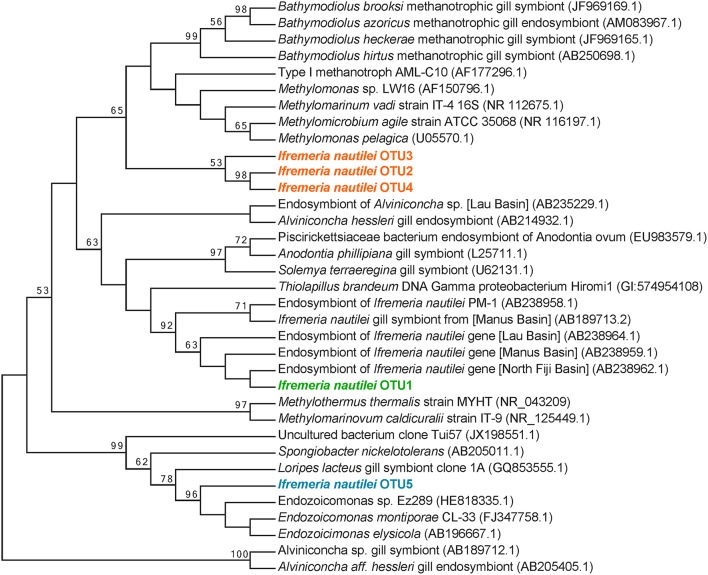
Maximum-likelihood phylogenetic tree of the top 5 most abundant 16S rRNA gene OTUs. The 5 OTUs shown here accounted for 98% of all 781 662 reads analyzed. The tree is based on 252 unambiguously aligned nucleotide positions. Two ε-proteobacterial Alviniconcha hessleri symbionts are used as the outgroup. The numbers to the left of each node are bootstrap values obtained from 1000 replicates; only values greater than 50% are indicated.